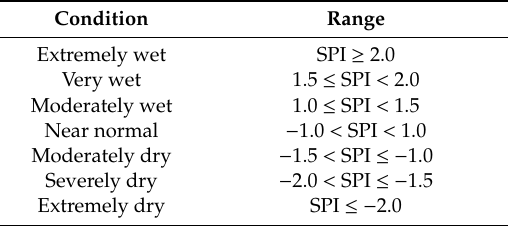
Table 2. Classification of drought conditions based on the SPI values